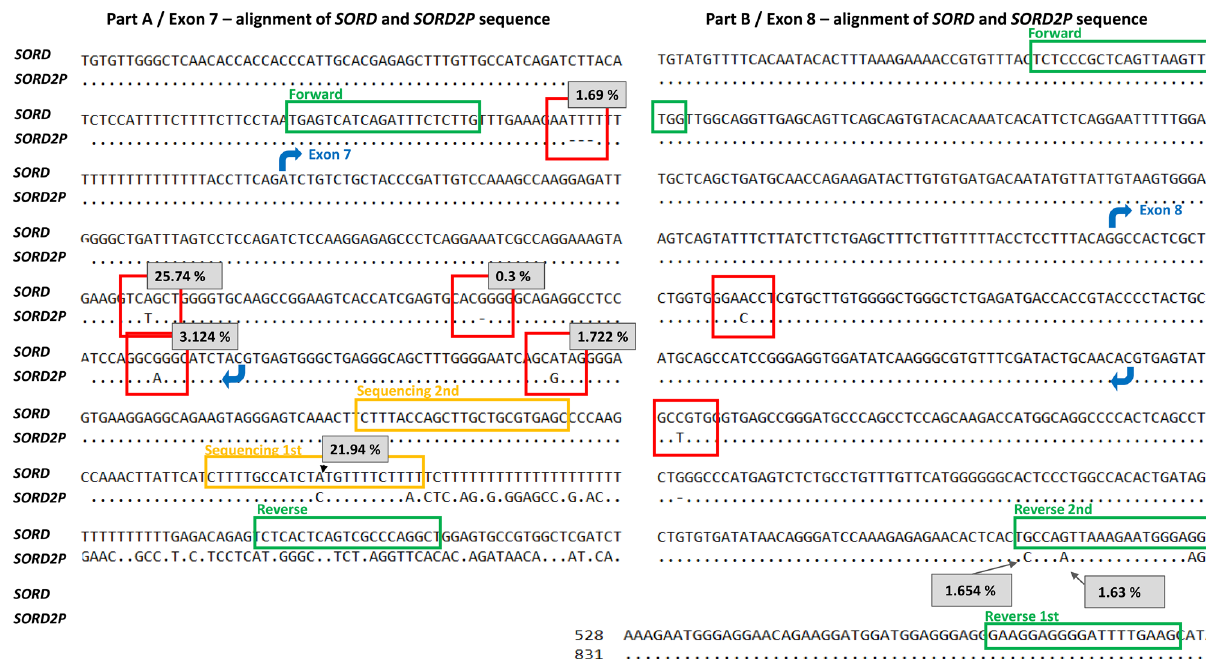
Figure 2. The sequence differences of SORD and SORD2P . Blast search for SORD and SORD2P with alignment view pairwise with dots for identities (https:// blast. ncbi. nlm. nih. gov). Several features are highlighted: red squares = differences; green rectangles = PCR primers; orange rectangles = sequencing primer; blue arrow = start and end of the exon; 1st primer = primer from original study; 2nd primer = our primer; grey rectangles with % = population frequency of that SNP in gnomAD for